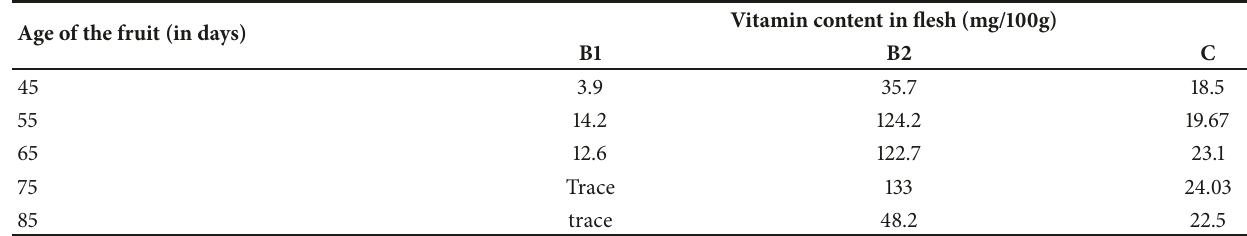
Table 2: Changes in vitamins in jackfruit flesh.